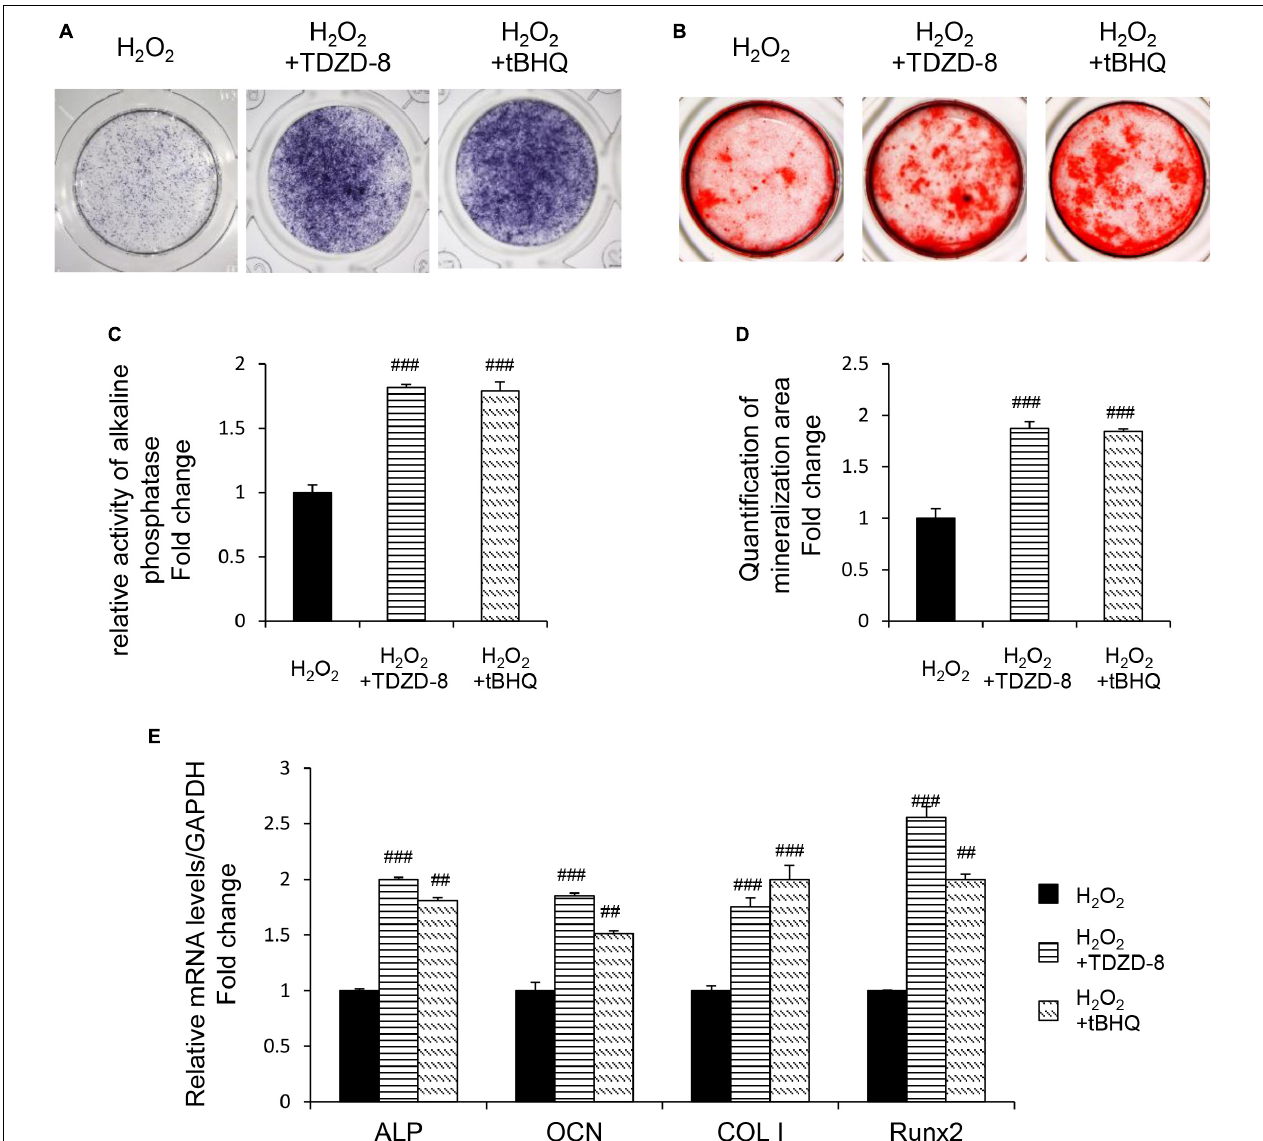
FIGURE 5 | GSK3 β -Nrf2 signaling pathway is involved in H 2 O 2 -induced osteoblast dysfunction. The MC3T3-E1 cells were treated in the osteogenesis differentiation medium with or without H 2 O 2 for 6 h. TDZD-8 or tBHQ were added 1 h before H 2 O 2 . (A) After the cells cultured for 7 days and they were subjected to ALP staining in the indicated treatment groups. (B) The alizarin red staining of MC3T3-E1 cells showed the mineralizing matrix after cultured for 14 days. (C) ALP activity tested in MC3T3-E1 cells as indicated groups. (D) Mineralization capacity was evaluated by tests. (E) When cultured for 3 days the expression of osteogenic marker genes were analyzed. Data are presented as the mean ± SD from at least three independent experiments. * p < 0.05, ** p < 0.01, *** p < 0.001, versus C group; NS, non-significantly different from C group. # p < 0.05, ## p < 0.01, ### p < 0.001, versus the H 2 O 2 group; ns, non-significantly different from H 2 O 2